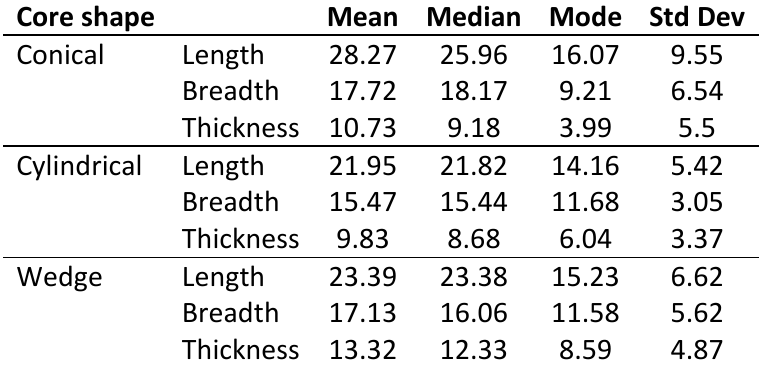
Table 5: Metric analysis of